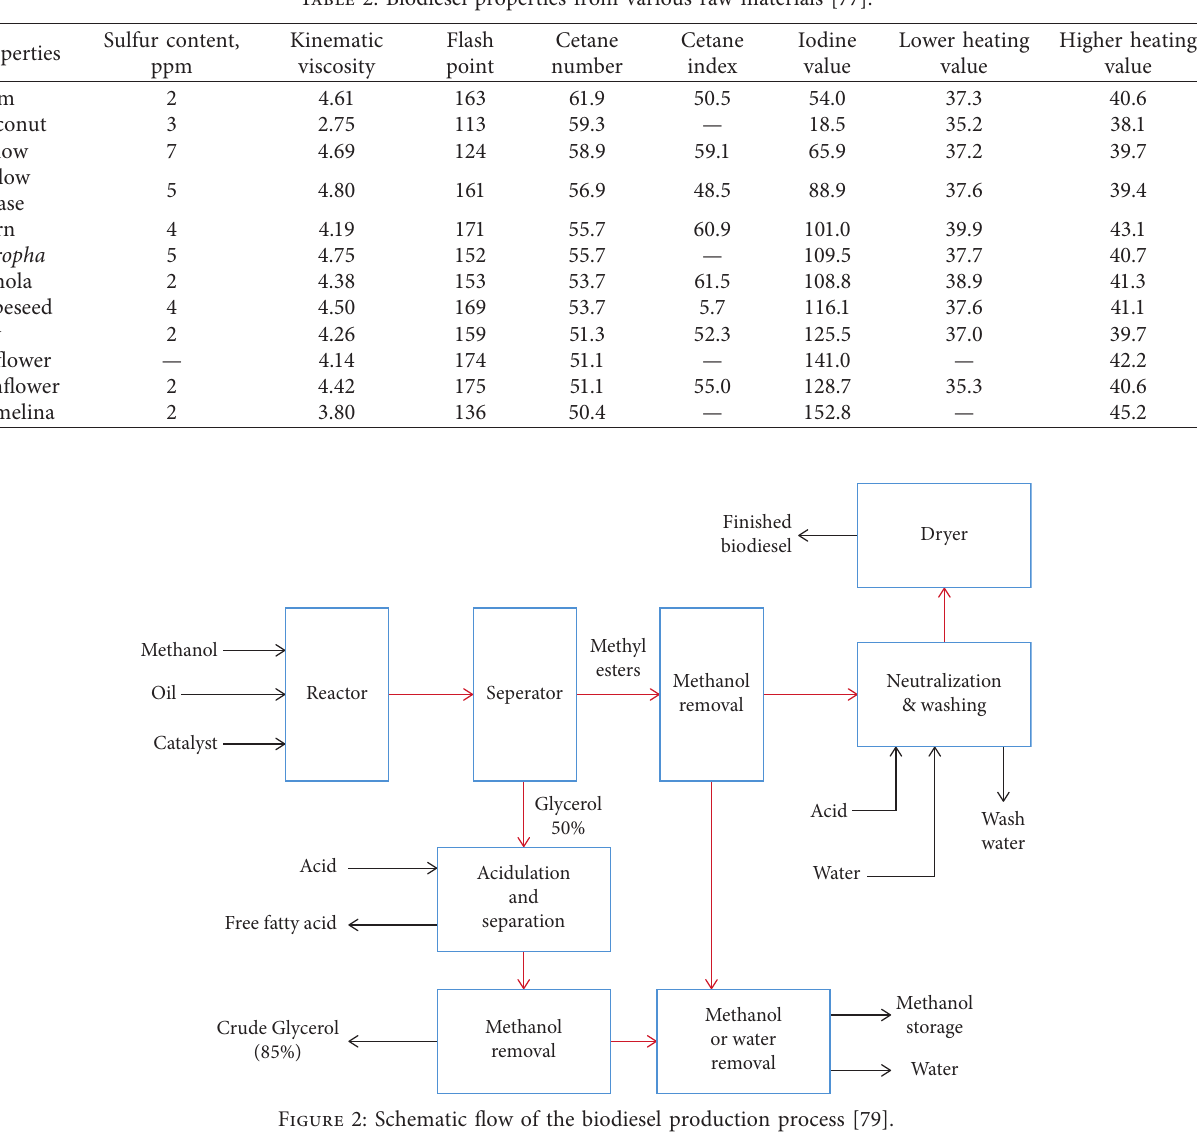
Table 2: Biodiesel properties from various raw materials [77].